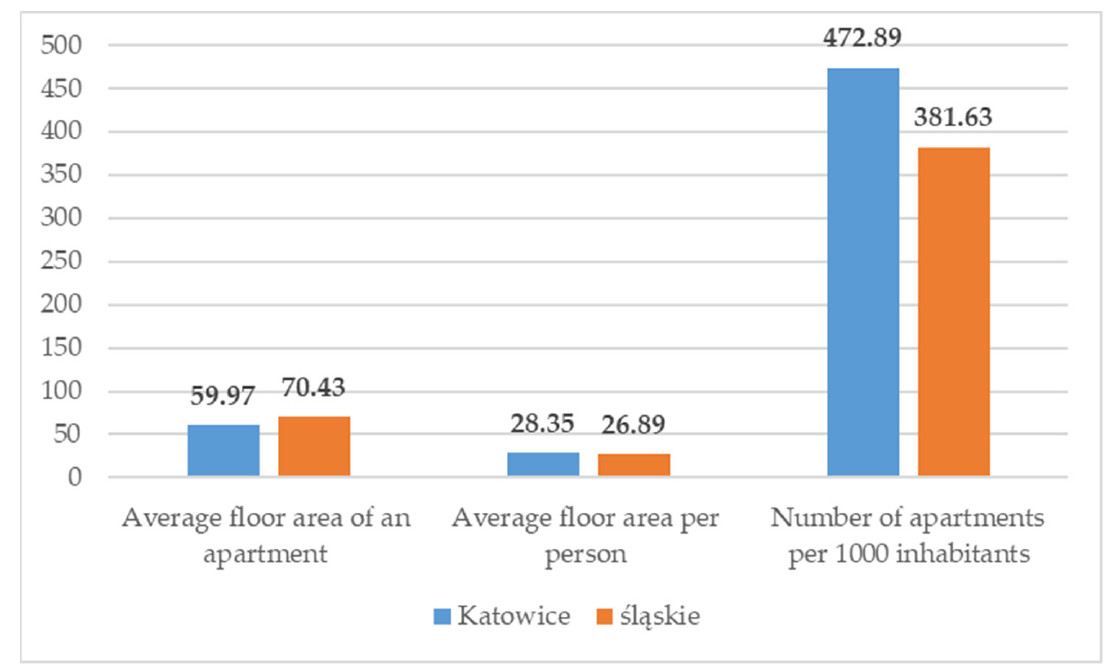
11 Figure 5. Indicators of housing infrastructure quality in Gda ń sk and the Pomeranian Province. The next city studied is Katowice, located in the Upper Silesian Coal District, where hard coal has been mined for the Polish power and heating industries for many years. It